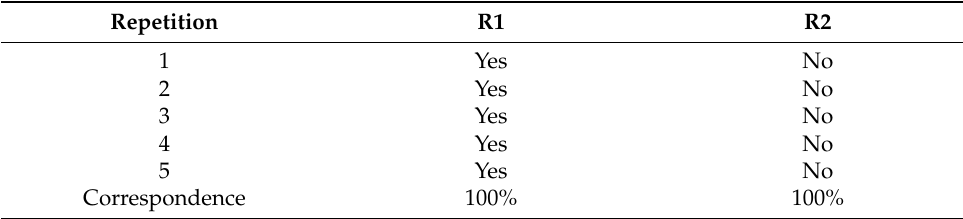
Table 4. Repeatability of IHC